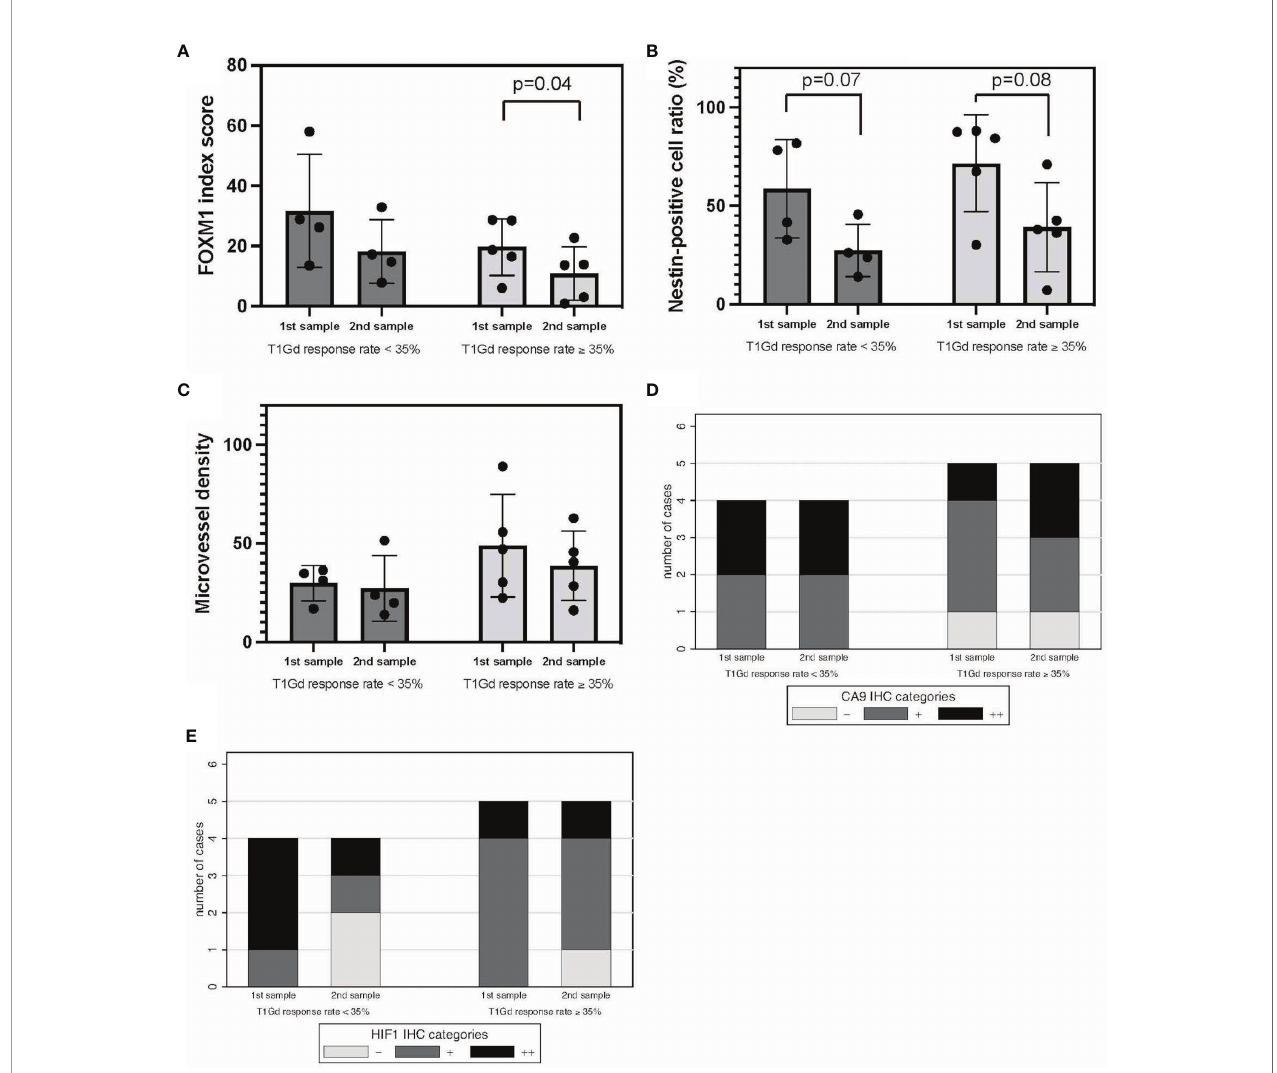
FIGURE 4 | T1Gd-GRs vs. T1Gd-PRs in tumor oxygenation, stemness, and immunological TME. FOXM1 (A) , nestin (B) , MVD (C) , CA9 (D) , and HIF-1 a expression (E) . Error bar; standard deviation. CA9, carbonic anhydrase 9; FOXM1, Forkhead box M1; GR, good rensponder; HIF-1 a , hypoxia inducible factor-1 alpha; MVD, microvessel density; PR, poor responder; TME, tumor microenvironment; T1Gd, T1-weighted images with gadolinium